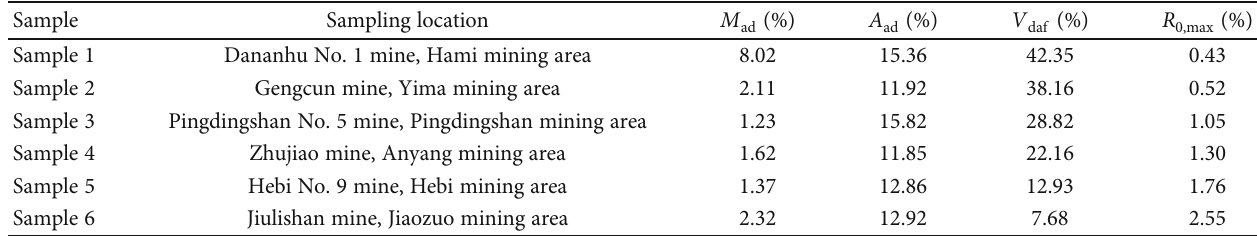
Figure 2: Sample preparation process and experimental steps. Table 1: Basic information and parameters of experimental coal samples.